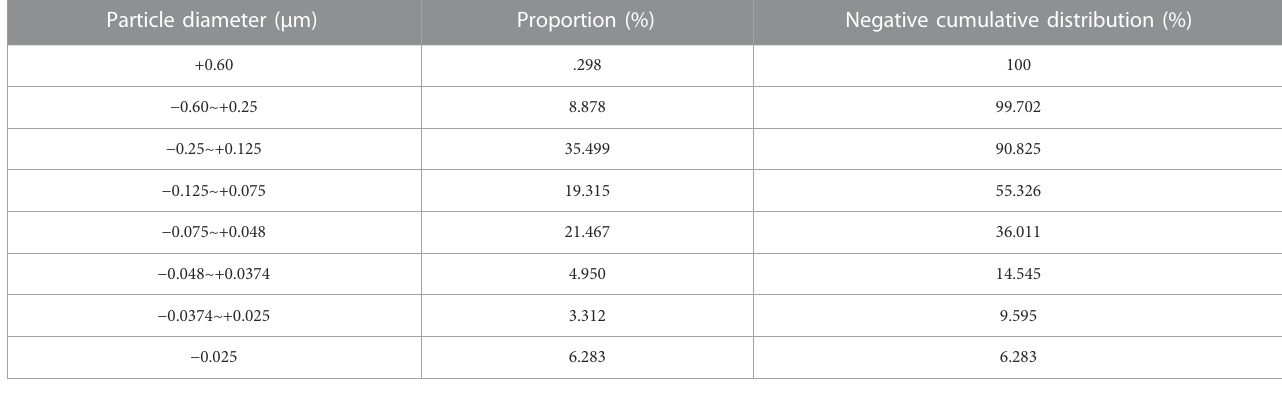
TABLE 2 Gradation of unclassi fi ed tailings.